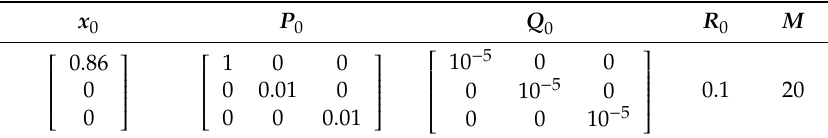
Figure 18. SOC estimation based on different models under DST profiles at 25 °C.